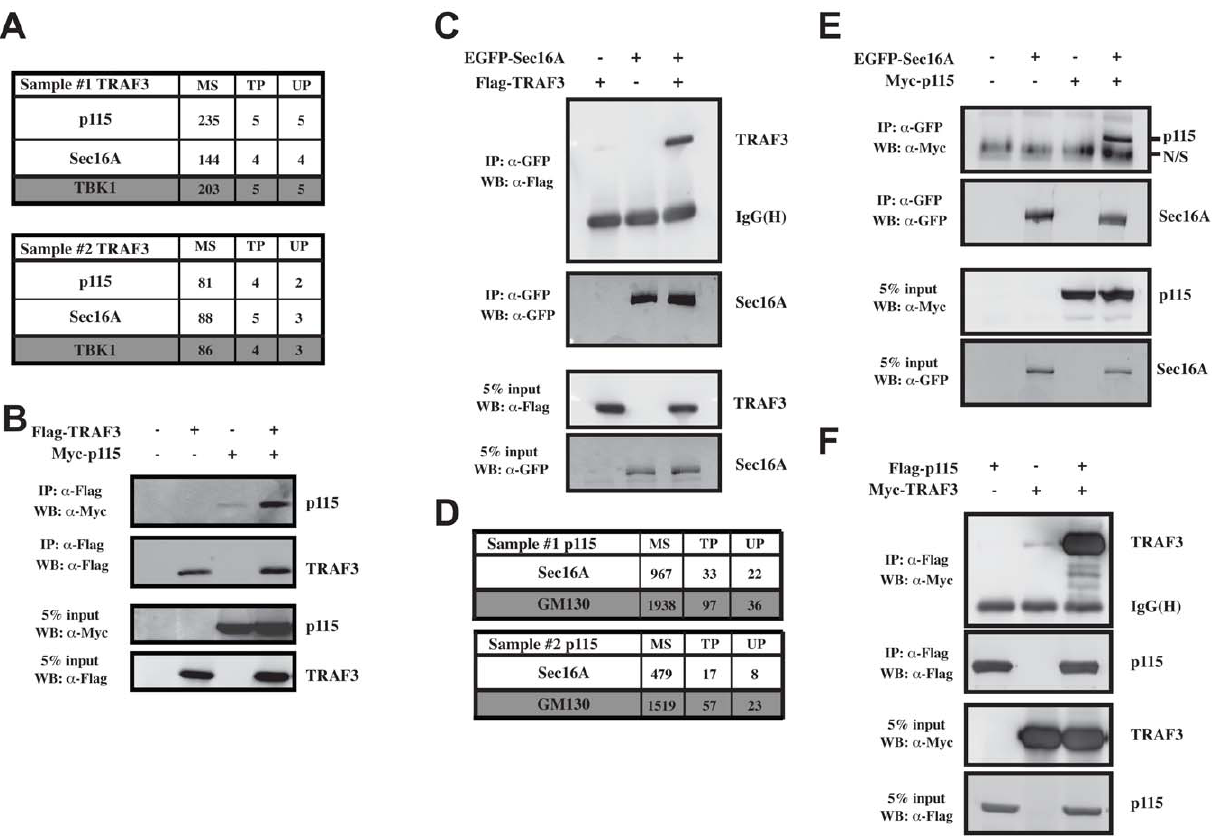
Figure 1. Identification of p115 and Sec16A as new TRAF3 interacting proteins. ( A ) HEK293 cells were stably transfected with pcDNA3- FLAG-TRAF3 or pcDNA3-FLAG alone. After G418 selection, the cells were lysed and subjected to AP/MS as described in Methods. The complete list of interactors is shown in Figure S1A. Data for p115 and Sec16A, which were not detected in immunoprecipitates of control cells, are shown here. MS; mascot score, TP; average total number of peptides (spectral counts) identified, UP; number of unique peptides observed; data from two biological replicates are shown. ( B ) Co-immunoprecipitation experiments showing the association of Myc-p115 to FLAG-TRAF3 when coexpressed in 293T cells. One of three independent experiments with similar results is shown. ( C ) Co-immunoprecipitation experiments showing the association of FLAG- TRAF3 to EGFP-Sec16A when coexpressed in 293T cells. One of three independent experiments with similar results is shown. ( D ) AP/MS analysis from cells stably transfected with pcDNA3-FLAG-p115 or pcDNA3-FLAG vector and analyzed as described in A). ( E ) Co-immunoprecipitation experiments showing the association of Myc-p115 to EGFP-Sec16A and ( F ) Myc-TRAF3 to FLAG-p115 when coexpressed in 293T cells. One of three independent experiments with similar results is